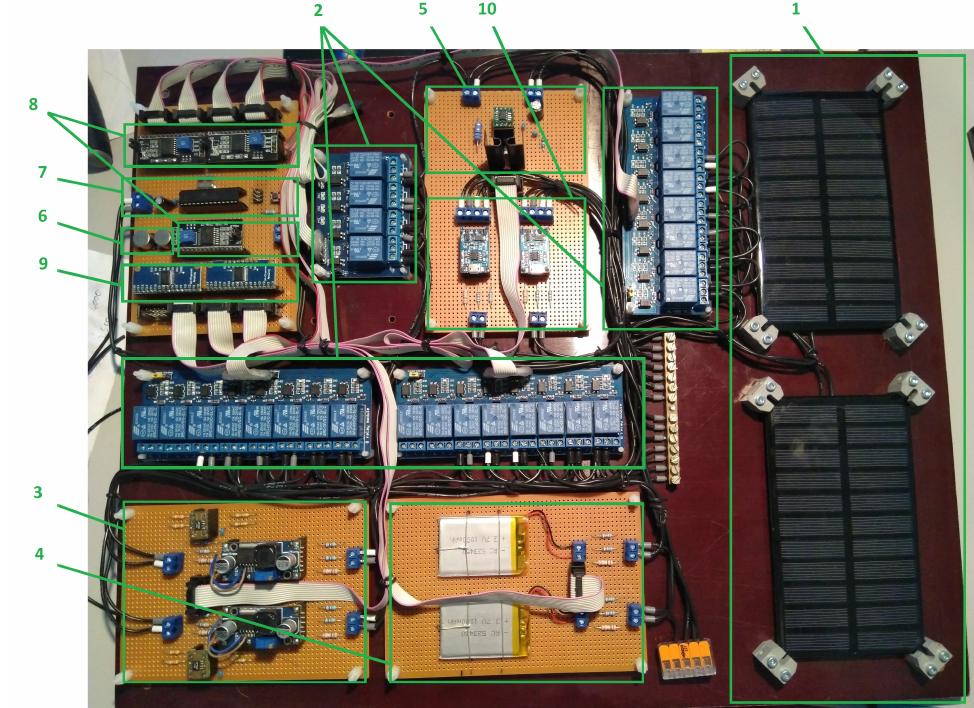
Figure 9. Experimental